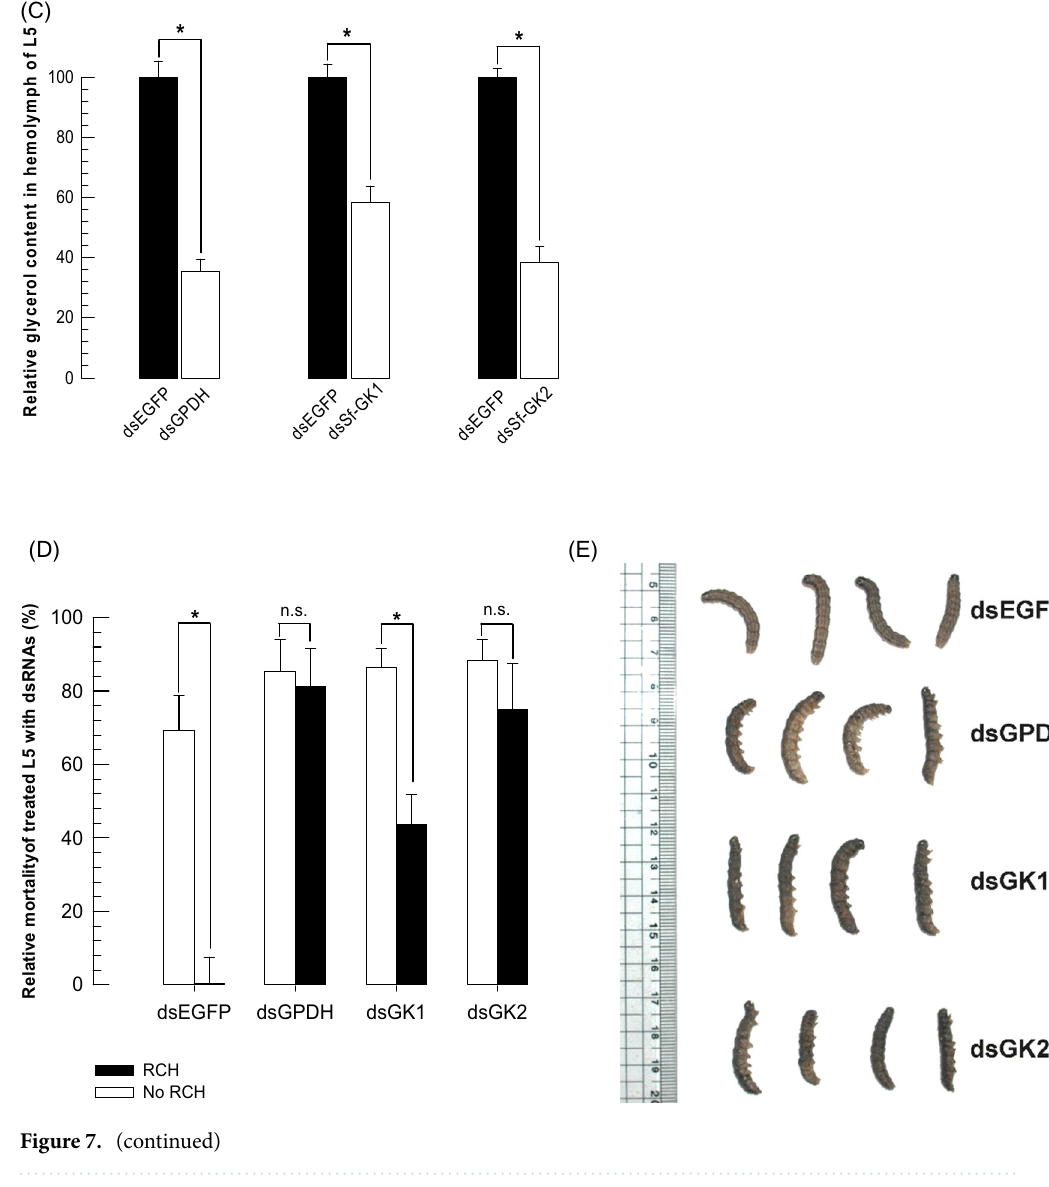
Glycerol (mM)/hemolymph of fifth instar